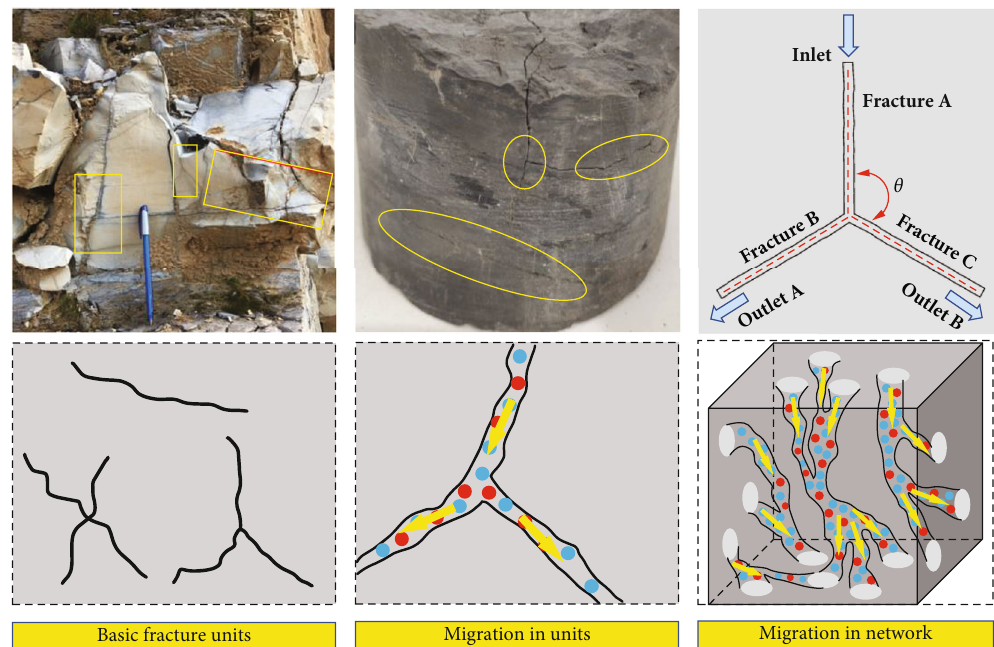
Figure 1: Schematic diagram of extraction and simpli fi cation of the Y-shaped fracture. The red and blue parts represent two di ff erent kinds of fl uids, respectively, such as gas, water, or oil, and the yellow arrow represents the fl uids fl ow